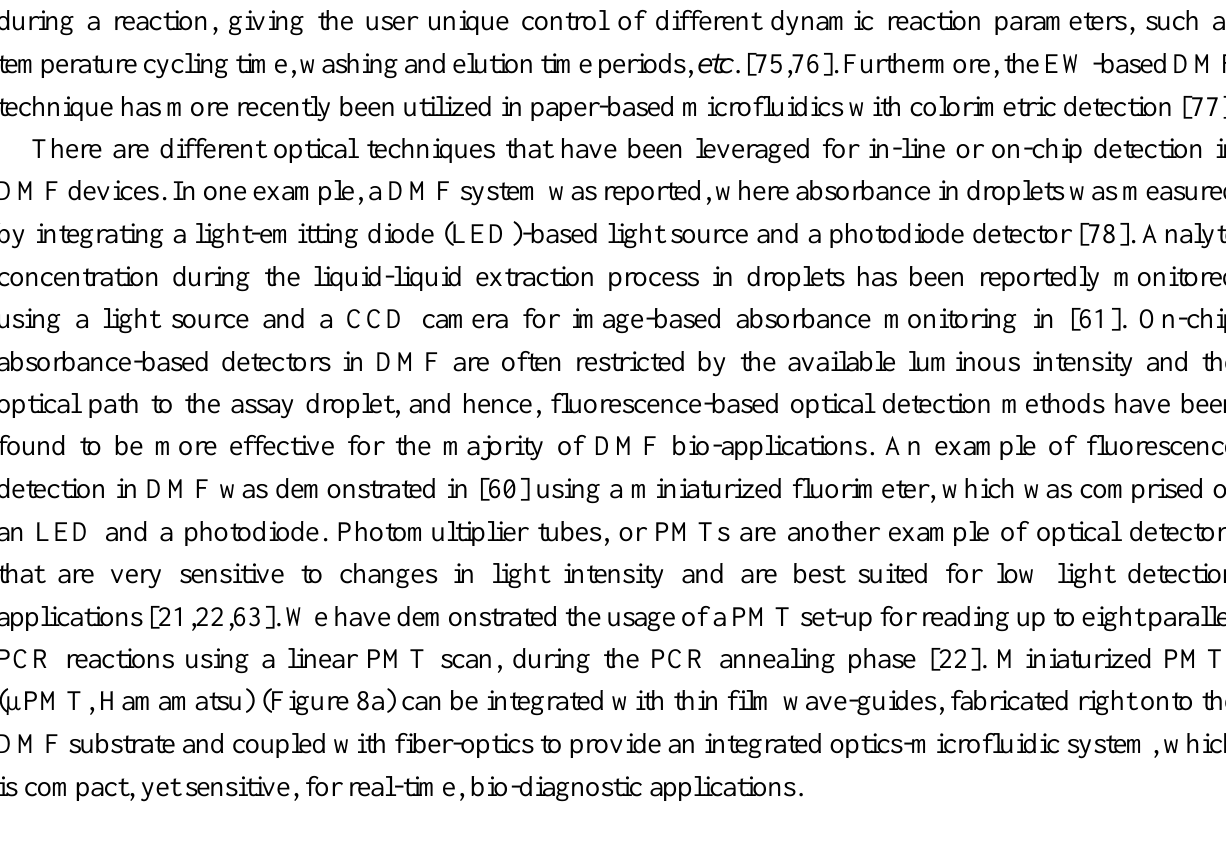
Figure 8. ( a ) Schematic diagram of an opto-microfluidic system with scanning micro photomultiplier tubes (µPMT) for multiplexed assay read-outs; ( b ) label-free detection using SPR and a nanostructured surface (reproduced with permission from